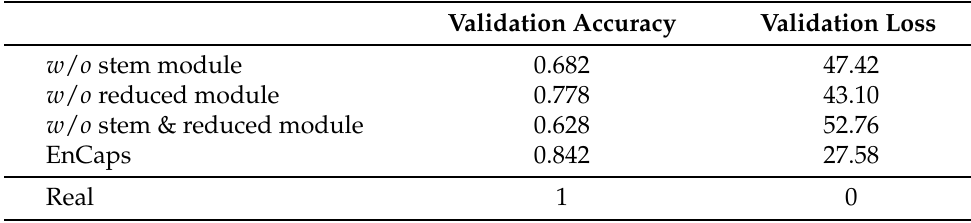
Table 3. Ablation experiments of